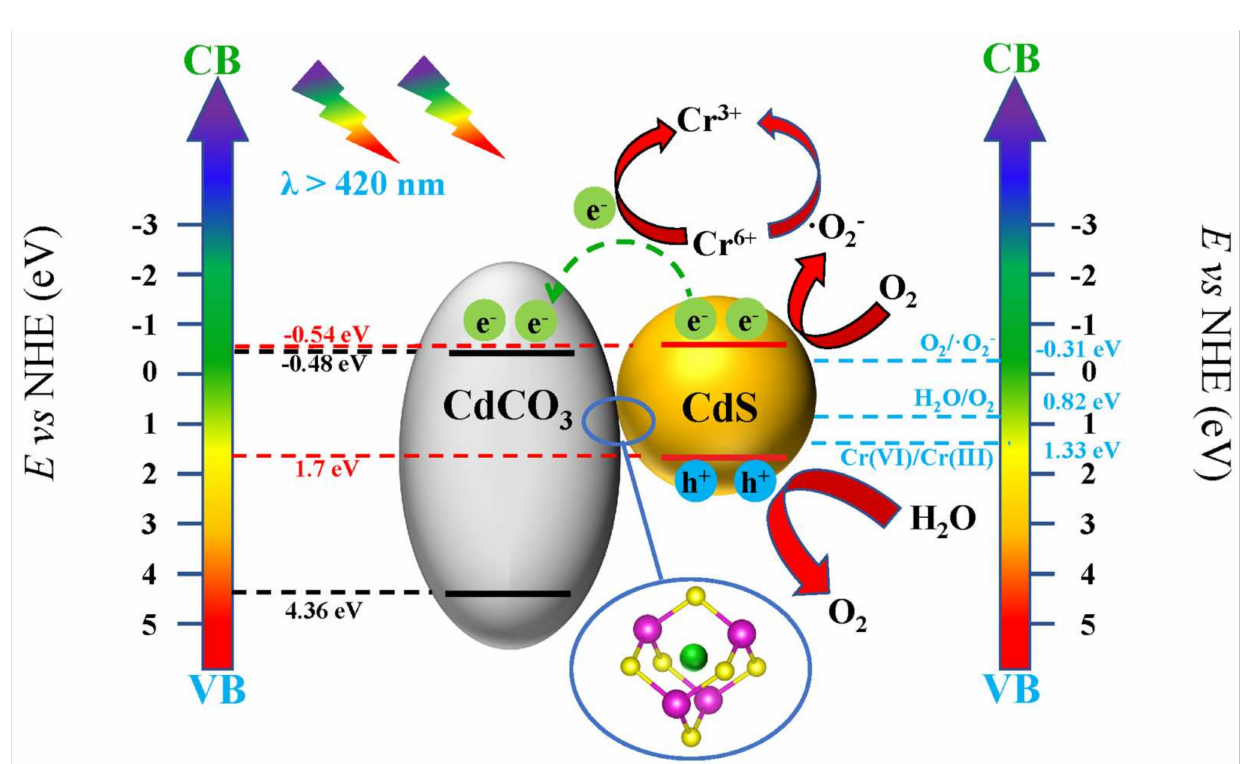
Figure 8. Schematic illustration of Cr(VI) photoreduction on 5 − CdS/CdCO 3 @SDS under simulated sunlight